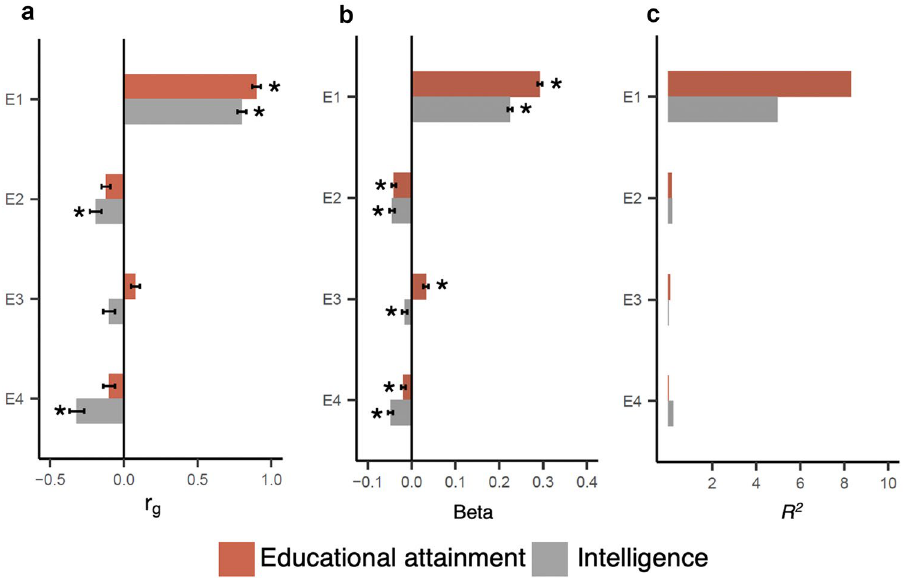
Figure 2. Genetic associations of E-factors with educational attainment and intelligence. ( a ) Genetic correlations (r g ) of the E-factors with educational attainment and intelligence estimated using bivariate LD score regression; ( b , c ) Associations of polygenic scores for educational attainment and intelligence with the E-factors. Standardised effect sizes (beta coefficient) are shown in ( b ) and variances explained (R 2 ) are shown in ( c ). Star symbols indicate statistical significance after multiple testing corrections (P <